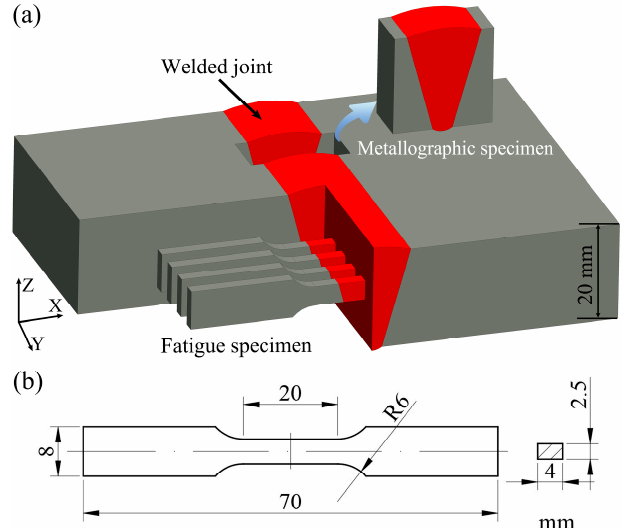
Figure 2. Test specimen of ( a ) the cut sample design and ( b ) the corresponding dimensions.